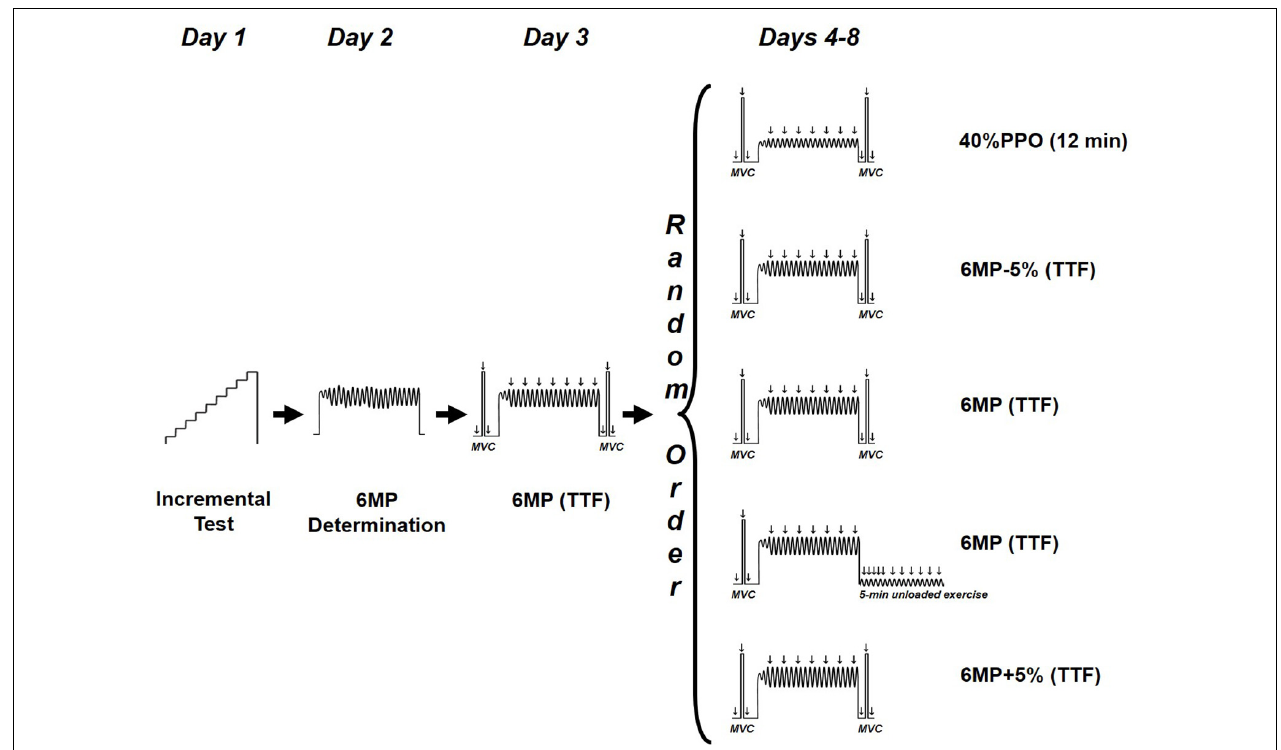
FIGURE 1 | Study design. TTF, time to task failure; 6MP, power eliciting task failure within 6 min; PPO, peak power